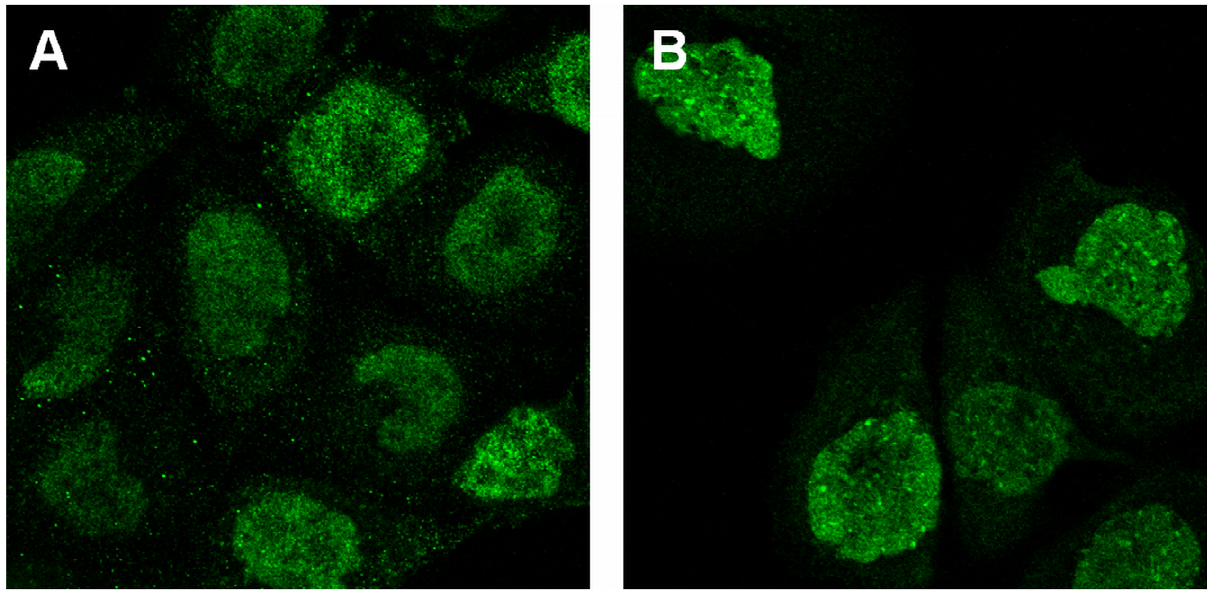
Figure 3. Examples of mis-annotated proteins identified by the hierarchical clustering reannotation method. (a) Protein ‘‘S100 calcium binding protein A12’’ was identified in the first round analysis. The image of the protein was visually annotated as ‘‘nucleus’’ but was annotated as ‘‘nucleus without nucleoli’’ by clustering. (b) Protein ‘‘Rho/Rac guanine nucleotide exchange factor (GEF) 2 0 was identified in the second round analysis. The image of the protein was visually annotated as ‘‘nucleus’’ but was annotated as ‘‘nucleus without nucleoli’’ by clustering. In both cases the latter annotation was chosen upon re-examination.